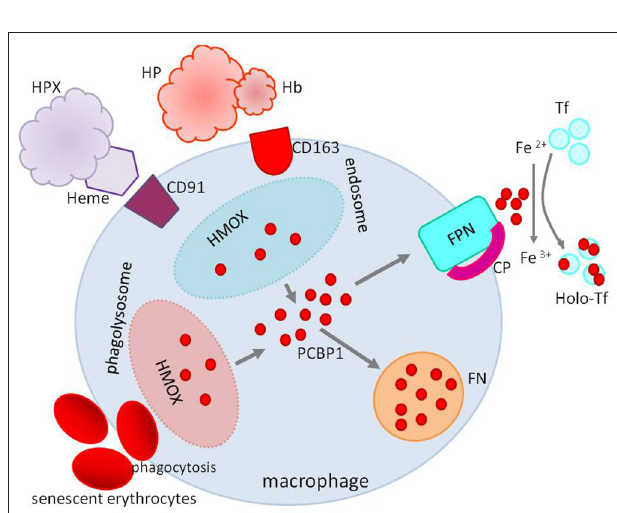
FIGURE 4 | Iron recycling in macrophages. Macrophages recover iron from phagocytized erythrocytes and heme from heme–HPX or HP–hemoglobin complexes after degradation by HMOX. Iron not used in the macrophage is stored in FN or exported to the circulation by FPN with CP’s cooperation. Heme–HPX, heme–hemopexin; HP-Hb, haptoglobin–hemoglobin; HMOX, heme oxygenase; FPN, ferroportin; CP, ceruloplasmin; FN, ferritin; Tf, transferrin; Holo-Tf, holotransferrin; PCBP1, poly(rC)-binding protein 1.